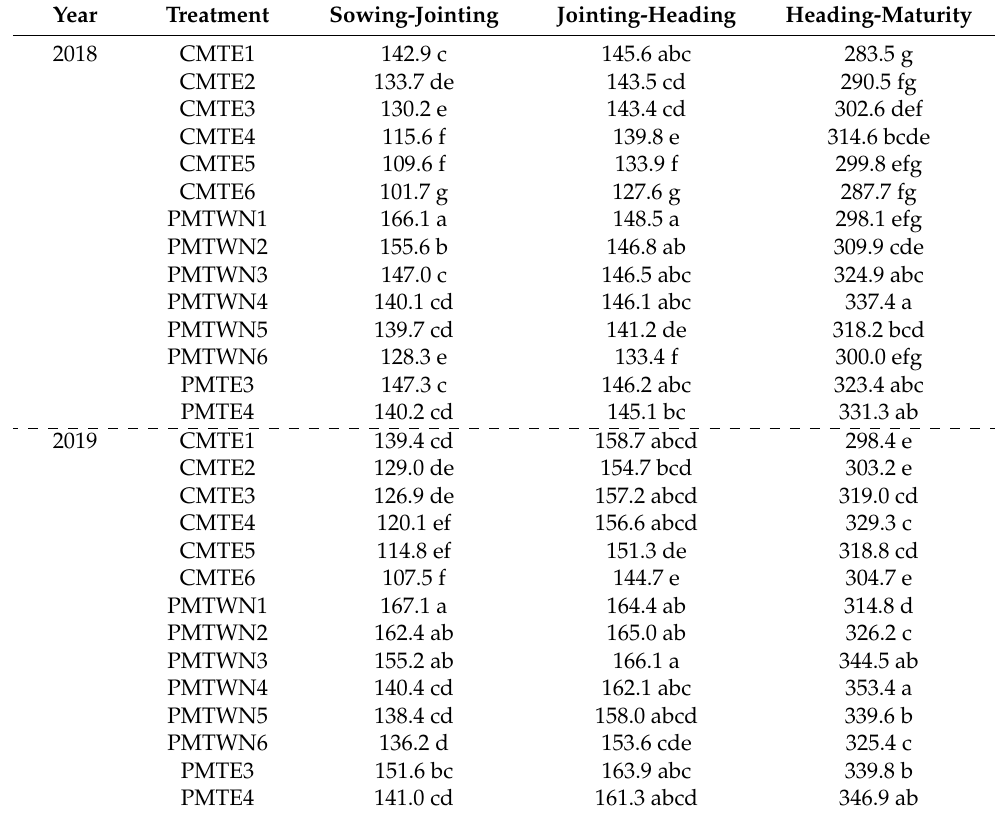
Table 4. Photosynthetic potential of rice under different mechanical transplanting methods and planting geometry.